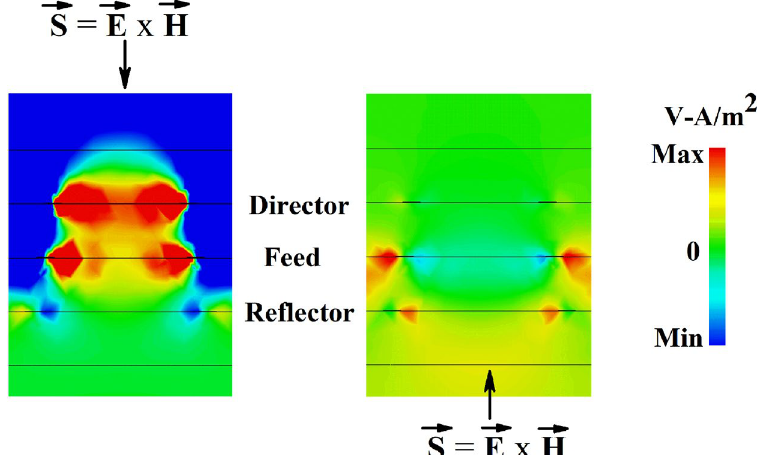
Figure 5. Power flow in the structure for front side (left) and back side illumination (right).